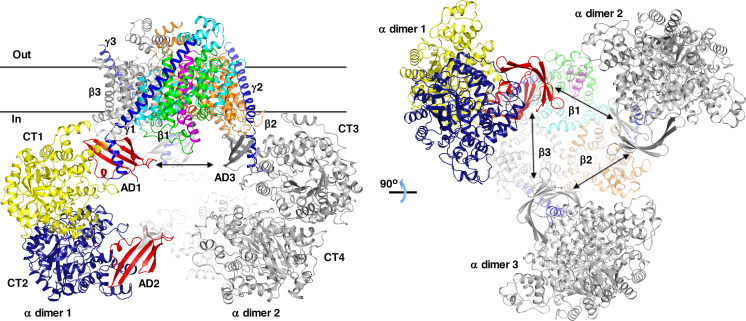
model of the OAD holoenzyme.The α subunit dimer is modeled based on the structure of pyruvate carboxylase (PDB 3BG5), whose CT and PT domains are homologous to the CT and AD domains in the α subunit. One of the AD domains in the α subunit dimer interacts with the γ subunit cytosolic tail. The BCCP domain is omitted due to its structural flexibility and small size. CT domains 1 and 2 in the α subunit dimer one are colored in yellow and blue, respectively; the AD domains are in red. α subunit dimers 2 and 3 are colored in gray. The arrows indicate potential interactions between the α subunit dimers. The black lines indicate boundaries of the membrane bilayer.